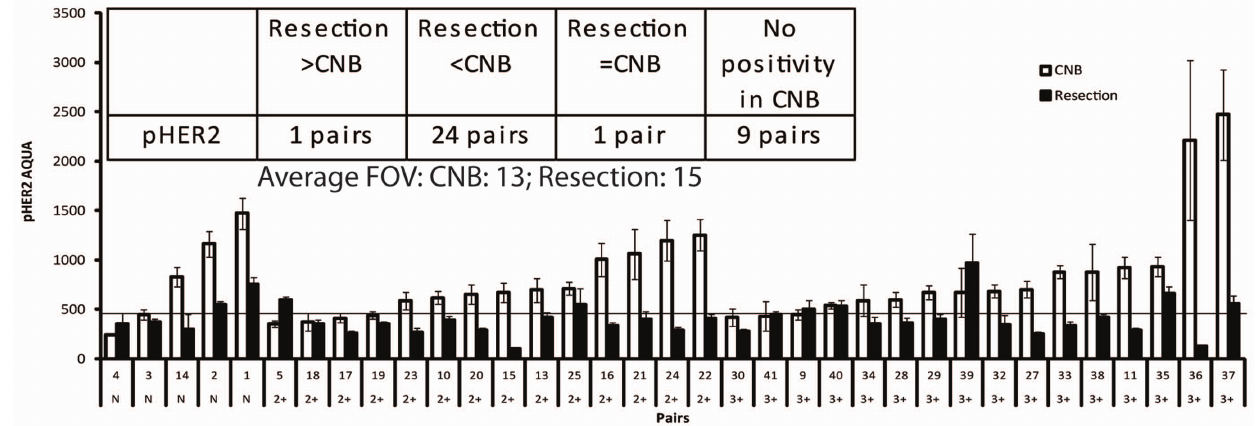
Figure 4. Expression of pTyr 1248 HER2 in paired specimens. A: AQUA pTyr 1248 HER2 scores for 35 pairs of CNB (open bars) and tumor resection (filled bars). Average FOVs of CNB: average number of FOVs included in analysis of core needle biopsies; Average FOVs of Resection: average number of FOVs included in analysis of tumor resection specimens. Each AQUA score represents the mean 6 95% CI. The noise cut point is presented as a solid line. The number of pairs where resections are higher than CNBs, lower than CNBs, or equal to those of CNBs are listed in inset.